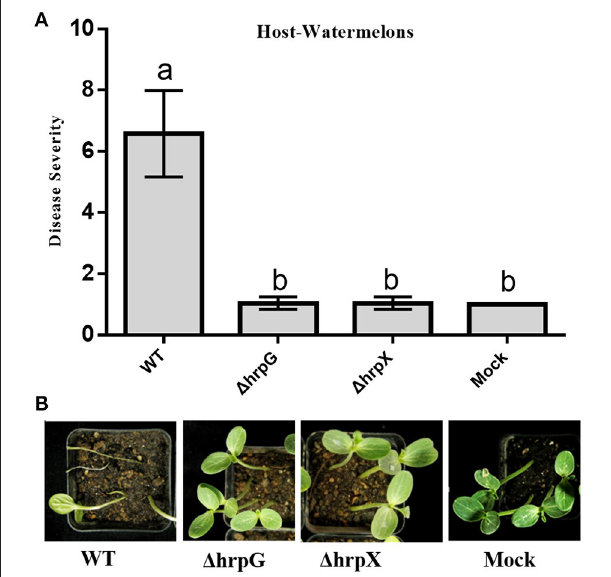
FIGURE 6 | Contributions of hrpG and hrpX gene to Acidovorax citrulli virulence. Bacterial fruit blotch severity on watermelon induced by wildtype (Aac5), hrpG and hrpX deletion mutants of A. citrulli in seedling transmission assays. Disease severity was assessed according to ( Bahar et al., 2009b). The experiment was conducted three times. (A) Disease severity of plants inoculated with different strains. The 10mM MgCl 2 was used as a mock treatment. Each column shows the mean and standard deviation. Different letters above bars indicate statistically significant differences as determined by one-way analysis of variance (ANOVA) and Tukey’s honest significant difference (HSD), p < 0.05; (B) representative picture was taken after 12 days by EOS 70D (Canon,